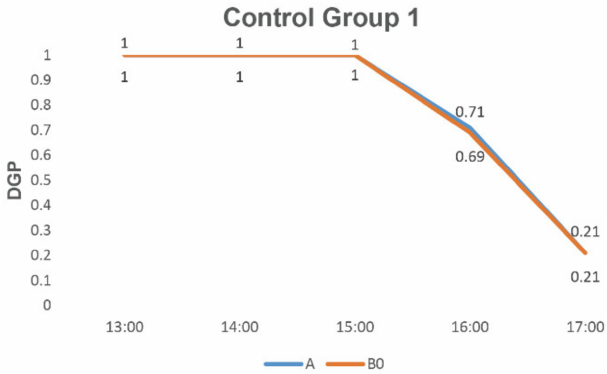
Figure 13. Comparation results of control group